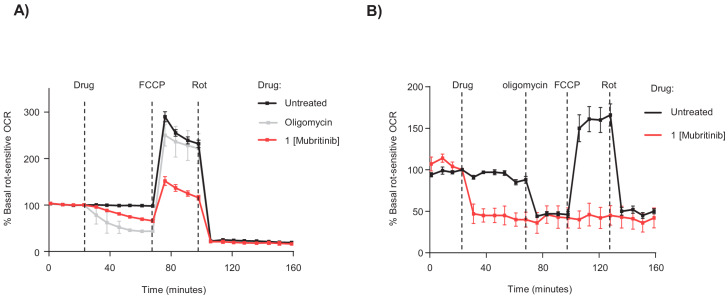
Mubritinib inhibits OCR in H9c2 and hESC-CM.(A and B) Representative seahorse trace (for Figure 2B) from (A) H9c2 or (B) hESC-CM cells in glucose containing media and treated with mubritinib (1 μM) or oligomycin A (1 μM).